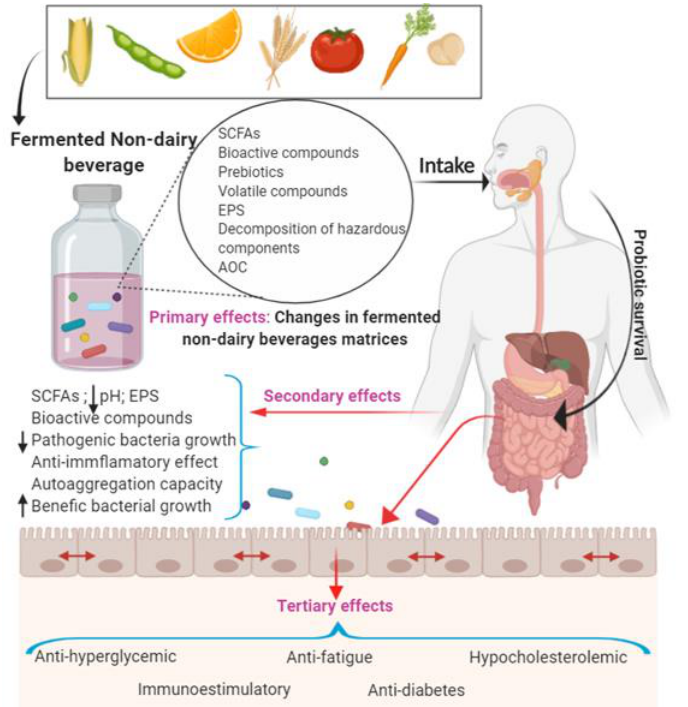
Figure 1. Summary of the beneficial effects of probiotics in different fermented non-dairy beverage matrices. Primary effects: changes in non-dairy matrices during fermentation. Secondary effects: changes in the intestinal epithelium. Tertiary effects: positive changes in health. SCFAs: short chain